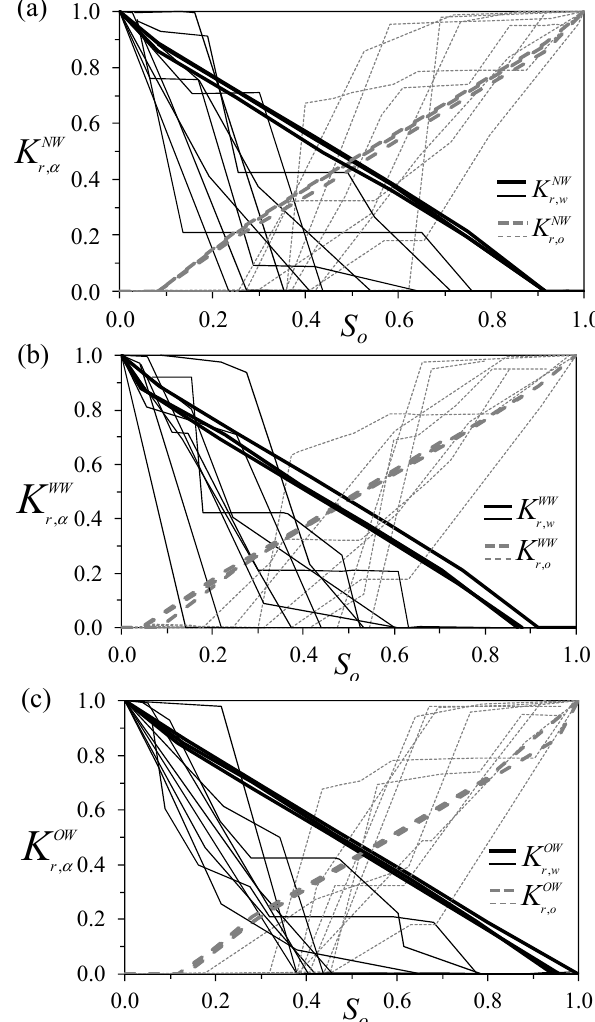
Figure 8. Relative permeability curves in the three regular settings (thick curves) and in the nine heterogeneous elementary cells (thin curves) for ( a ) θ = 90 ◦ (NW), ( b ) θ = 60 ◦ (WW), ( c ) θ = 120 ◦ (OW).